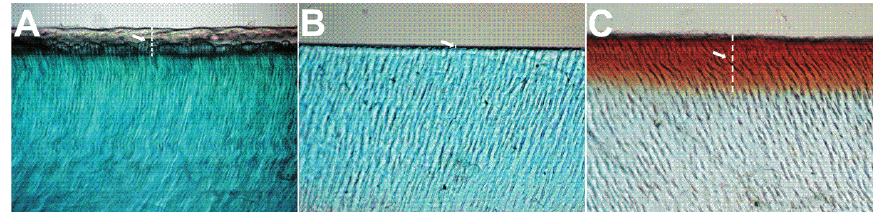
Figure 7- Polarized light microscopy photomicrographs (400x) of dentin lesions in each group after submitted to an artificial cariogenic challenge. Artificial carious lesions - areas of demineralization and staining (red) from grape seed extracted (arrows: negative birefringence areas); A- control group; B- 1000 ppm NaF; C-